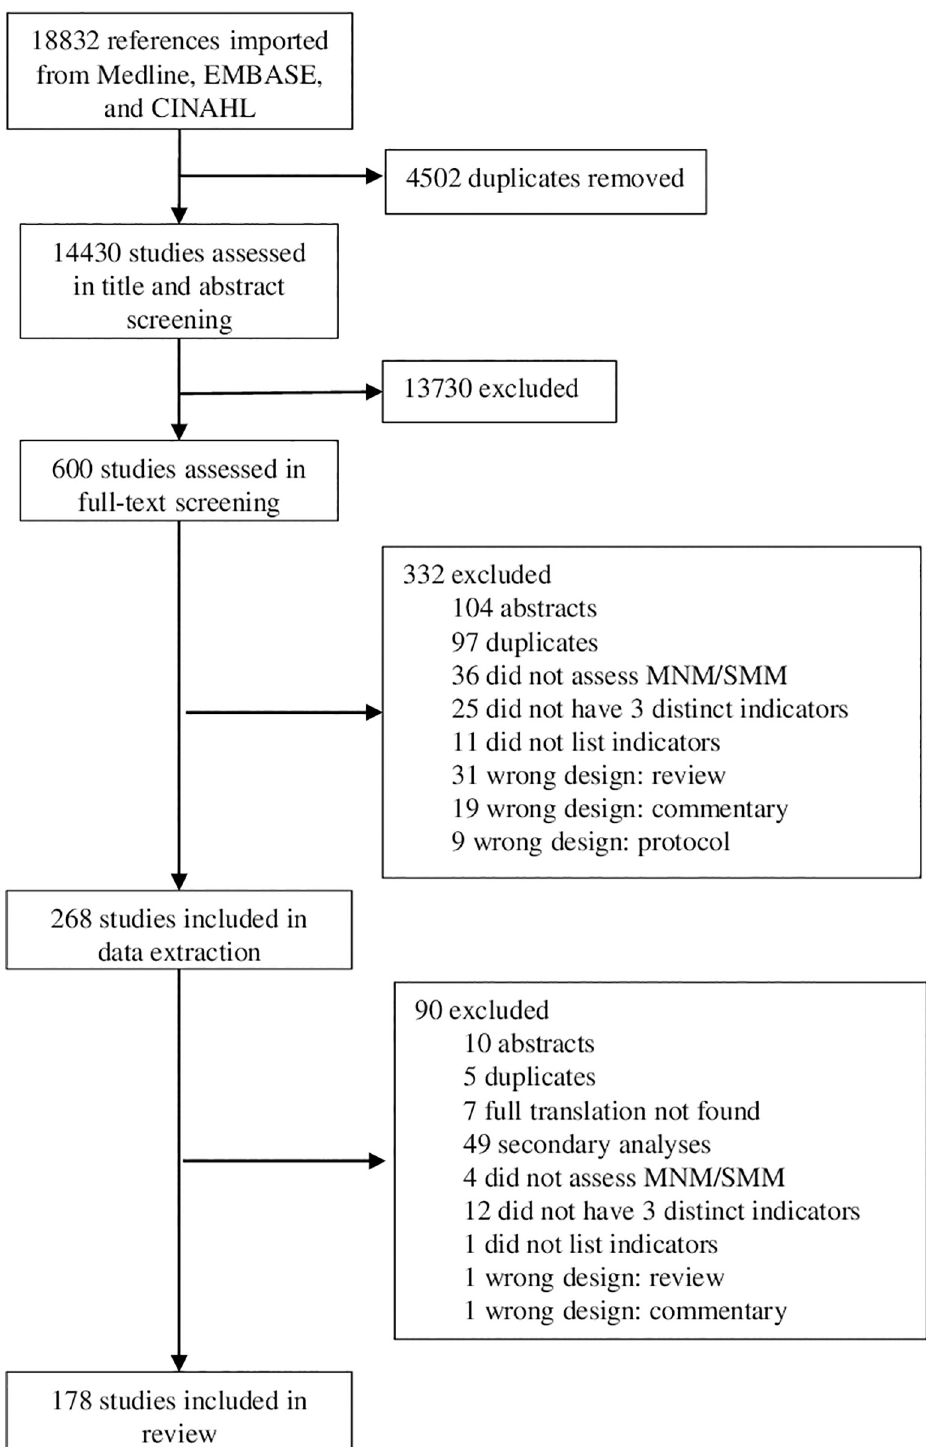
Fig 1. PRISMA flow diagram for systematic review of global monitoring practices for maternal near miss/severe maternal morbidity.